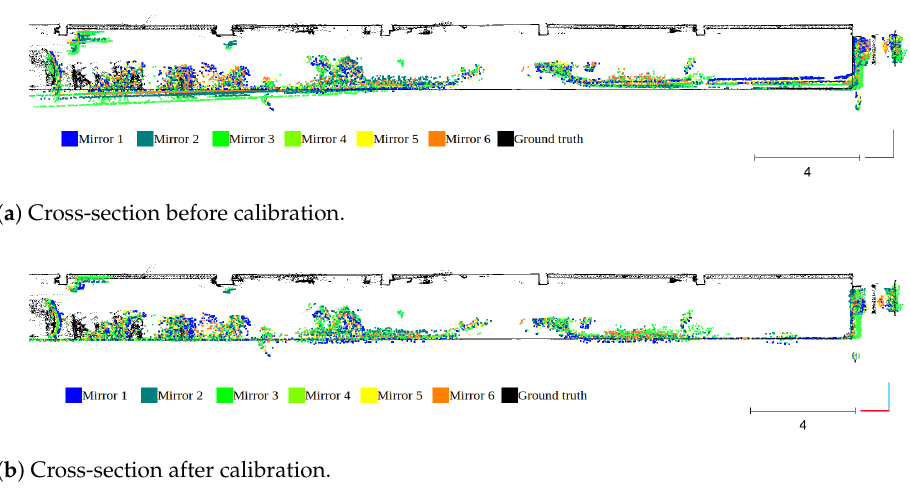
Figure 7. Qualitative result of the calibration impact on improved 3D data accuracy.